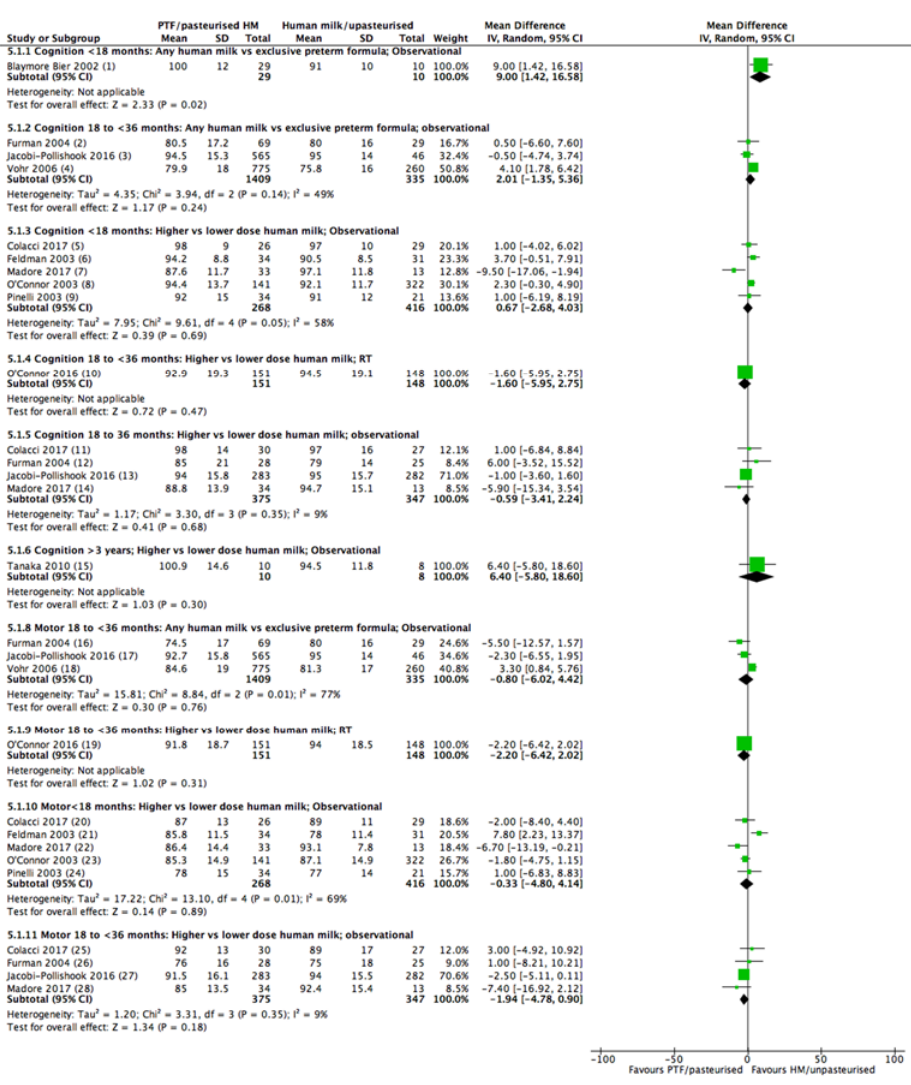
Figure 5. Forest plot of mean difference for association between human milk and neurodevelopmental scores. Footnotes: (1) BSID II MDI at 12 months, Mean adjusted for maternal Peabody Picture